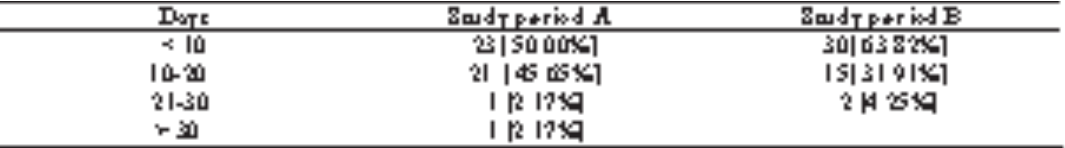
Majority of patients were discharged within three weeks of admission during both study period. Table IX : Perinatal